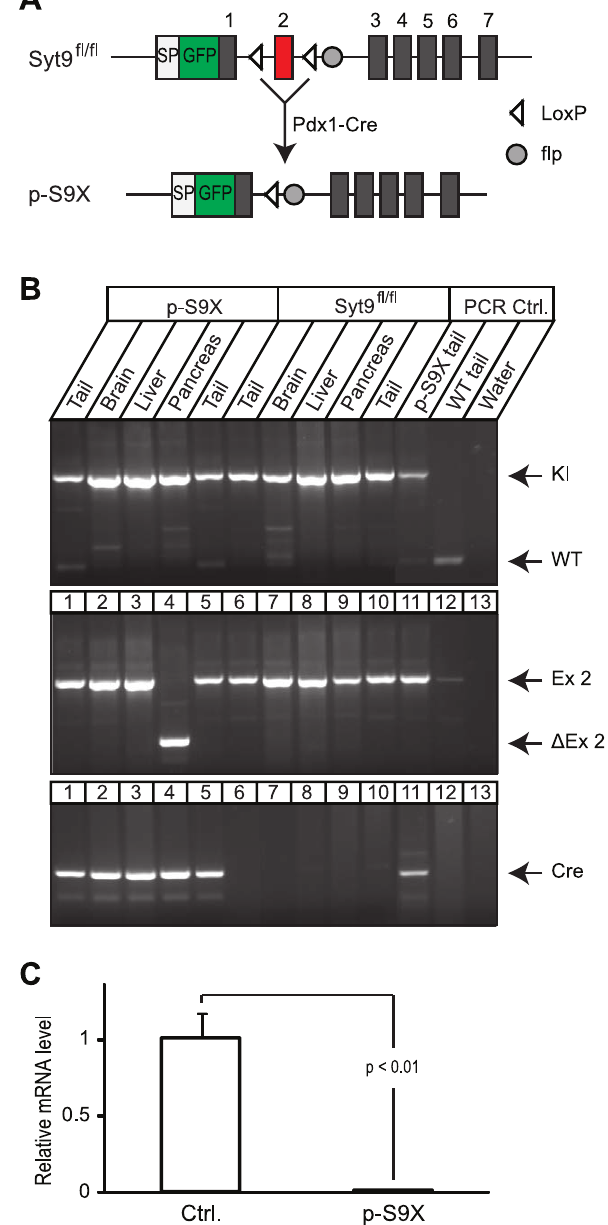
Figure 1. Generation of pancreas-specific synaptotagmin-9 KO (p-S9X) mice . ( A ) Homologous recombination and cre excision strategy for generating pancreas-specific synaptotagmin-9 KO mice. Syt9 fl/fl (synaptotagmin-9 fl/fl ) showing targeted exon 2 and flanking loxP sites, p-S9X showing synaptotagmin-9 gene structure after exon 2 deletion by cre recombination. ( B ) Representative genotyping patterns for p-S9X and Syt9 fl/fl mice. Note that deletion of exon 2 was only observed in the pancreas of p-S9X. ( C ) Synaptotagmin-9 mRNA levels were analyzed by quantitative real time PCR on total RNA extracted from p-S9X and Syt9 fl/fl (ctrl.) mouse islets. Data are presented as means 6 SEM. N=4 mice for each genotype. P , 0.01. doi:10.1371/journal.pone.0015414.g001 under curve for the first phase of insulin secretion or for the entire measurement period was the same in p-S9X and control mice (Figure 2C). These data indicate that glucose-stimulated insulin